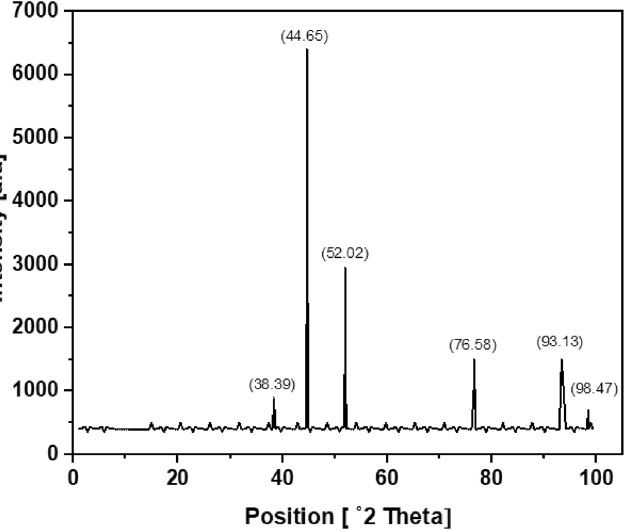
Figure 5. X-ray diffraction pattern of silver nanoparticles. Silver nanoparticles were synthesized from 1 mM silver nitrate treated with Bacillus cereus . The samples were sonicated, air-dried and the XRD pattern was observed.